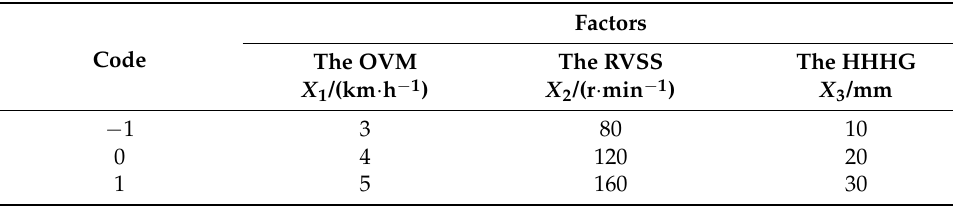
Table 2. Test factors and